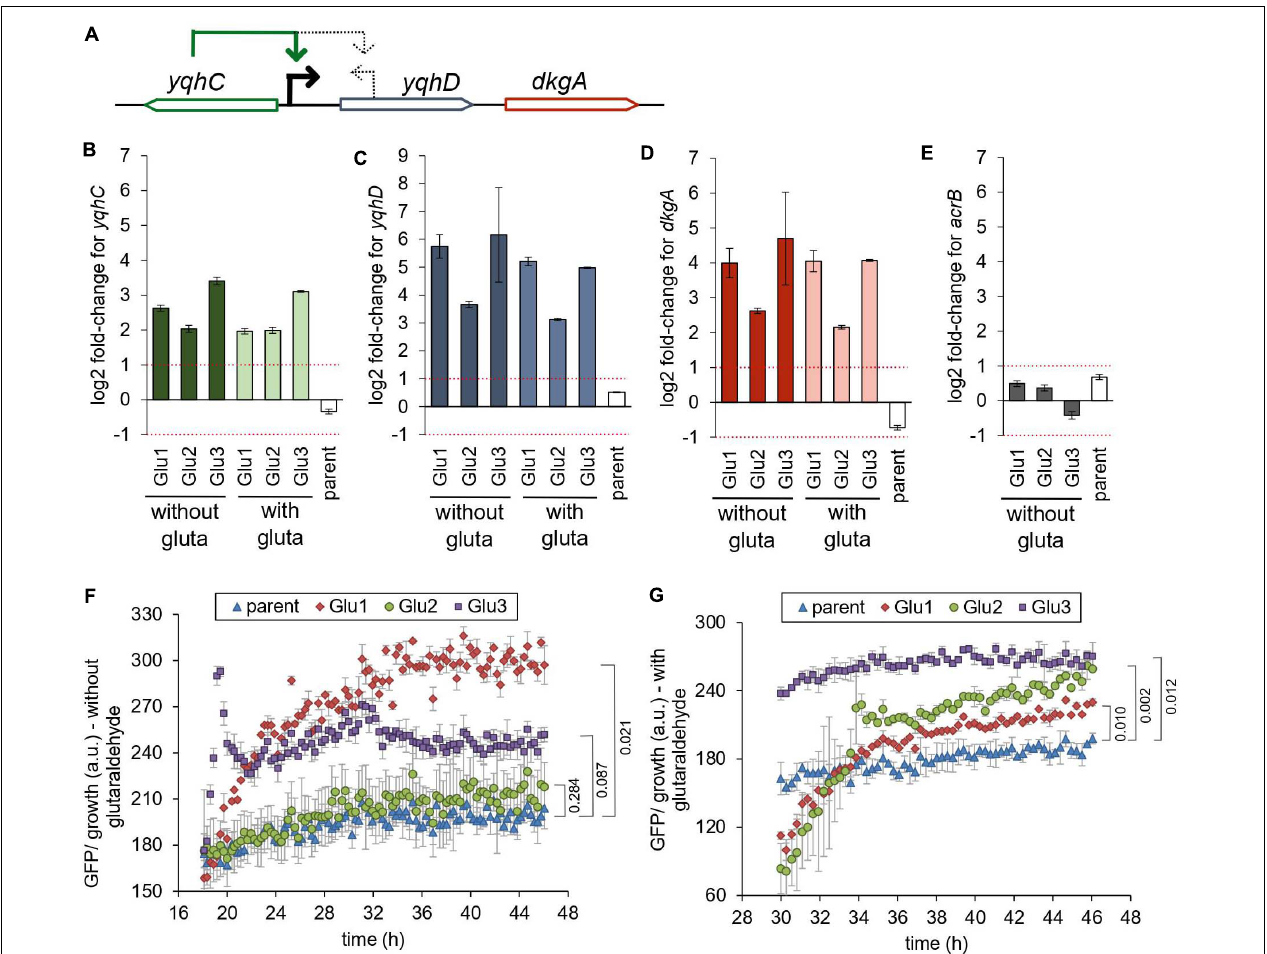
FIGURE 3 | Mutations in yqhC are associated with upregulation of yqhC , yqhD, and dkgA . (A) The transcriptional regulator yqhC activates the aldehyde reductase yqhD and the methylglyoxal reductase dkgA genes (Lee et al., 2010; Turner et al., 2011). (B–E) RT-qPCR results for (B) yqhC (C) yqhD, (D) dkgA, and (E) acrB expression for the strains evolved in glutaraldehyde, compared to the parent (non-evolved) strain, when grown in the presence or absence of glutaraldehyde. The column “parent” denotes the log2 fold-change between the parent strain in media containing glutaraldehyde compared to media without the biocide. The gene acrB was used as a negative control (less than twofold change between evolved and non-evolved strains). The experiments were performed in duplicate, and the error was calculated as described in “Materials and Methods” section (F,G) . Expression of GFP under the control of the yqhC predicted promoter in each of the